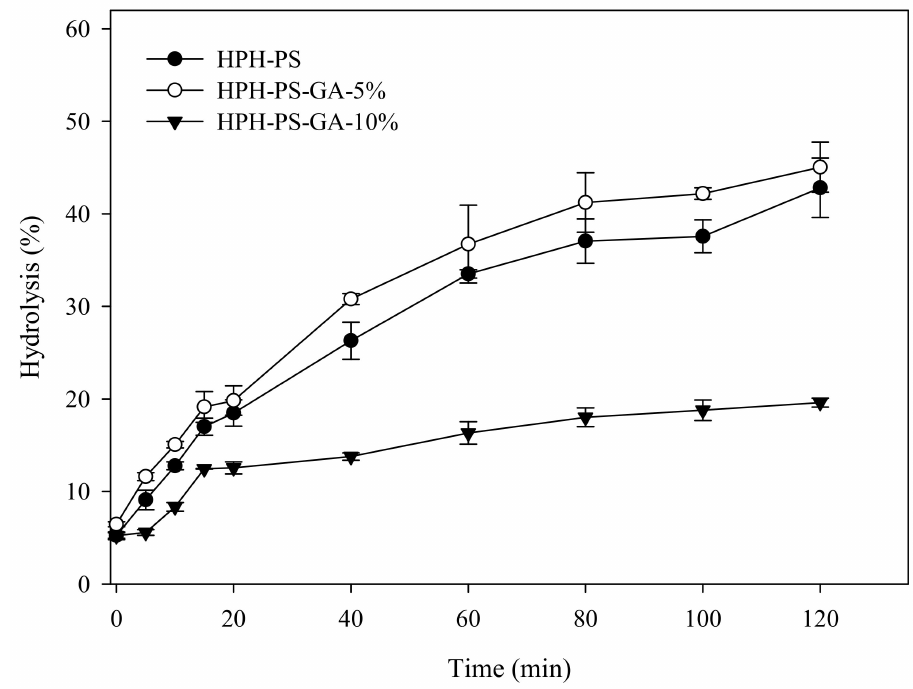
Figure 4. α -Amylase hydrolysis kinetics of high-pressure homogenization-processed pea starch with